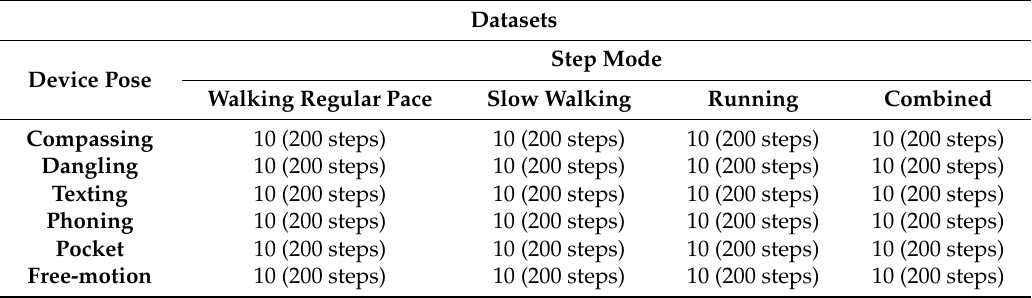
Table 2. Collected dataset